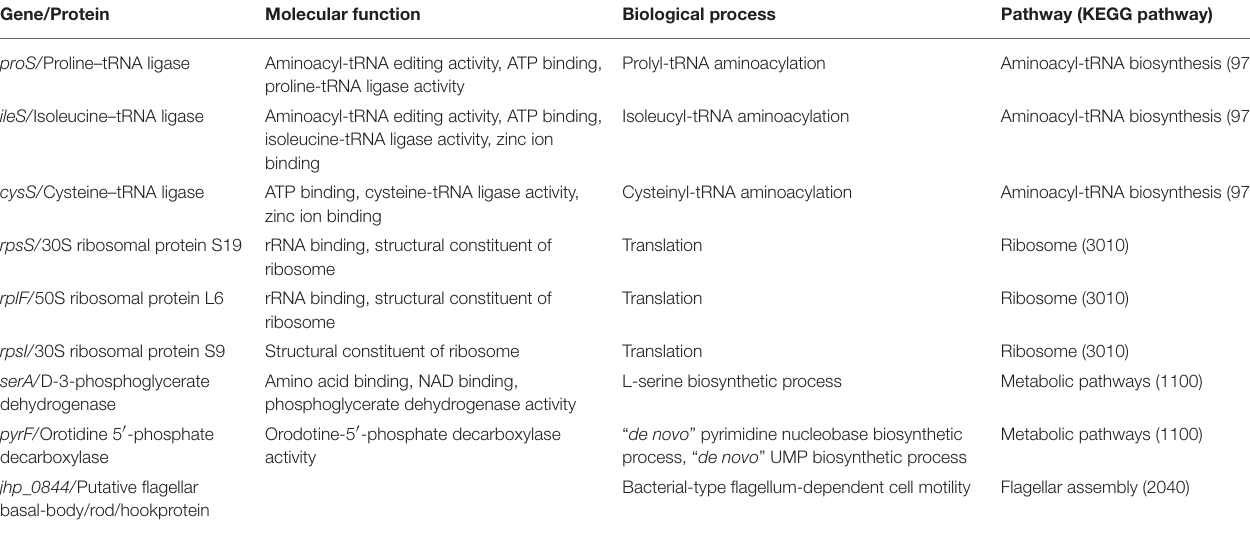
TABLE 5 | Proteins with differential expression among nine pairs of levofloxacin and metronidazole-resistant and sensitive strains.